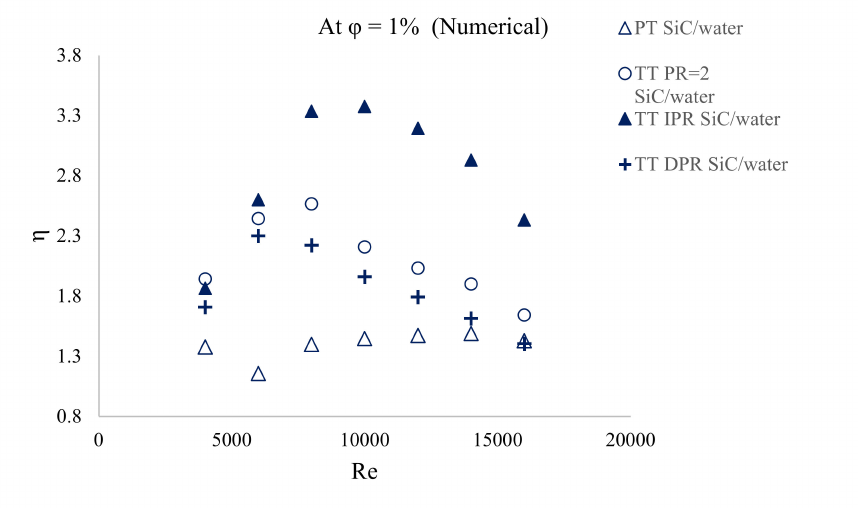
Figure 20. E ff ect of type of inserts on the overall enhancement ratio, η